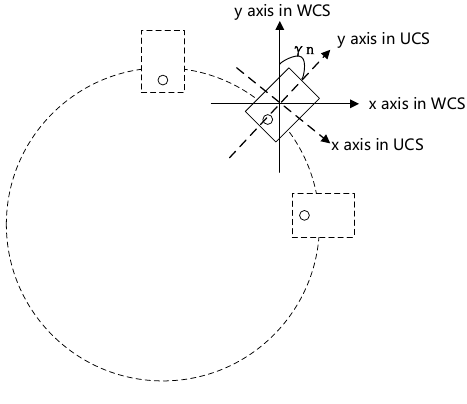
Figure 4. User’s phone coordinate system (UCS) to world coordinate system (WCS) when the phone is